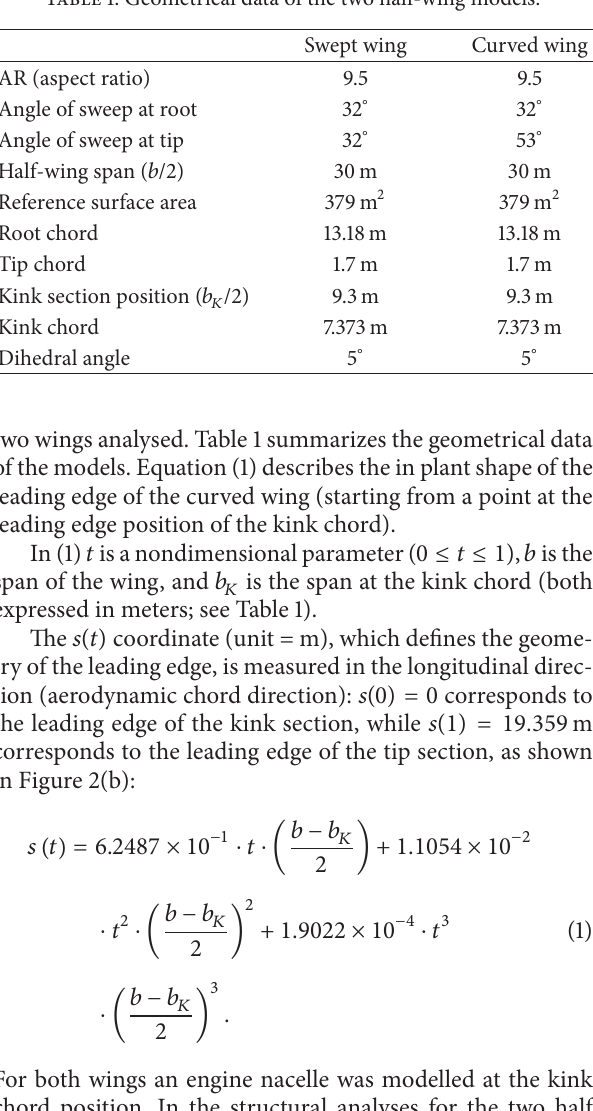
Table 1: Geometrical data of the two half-wing